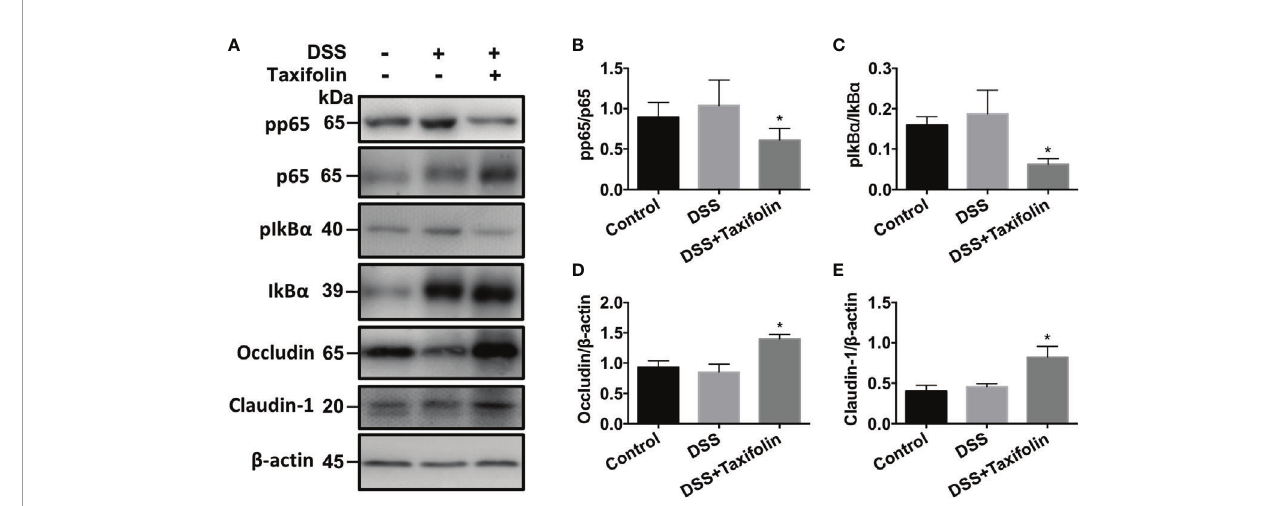
FIGURE 4 | Taxifolin inhibited the NF- k B signaling and increased tight junction protein expressions in colon tissues of mice. (A) Representative protein bands for pp65, p65, pI k B a , I k B a , occludin, and claudin-1; (B – E) Statistical analysis of protein bands. Data were expressed as means ± SEM ( n = 5). * P < 0.05 vs . DSS group.